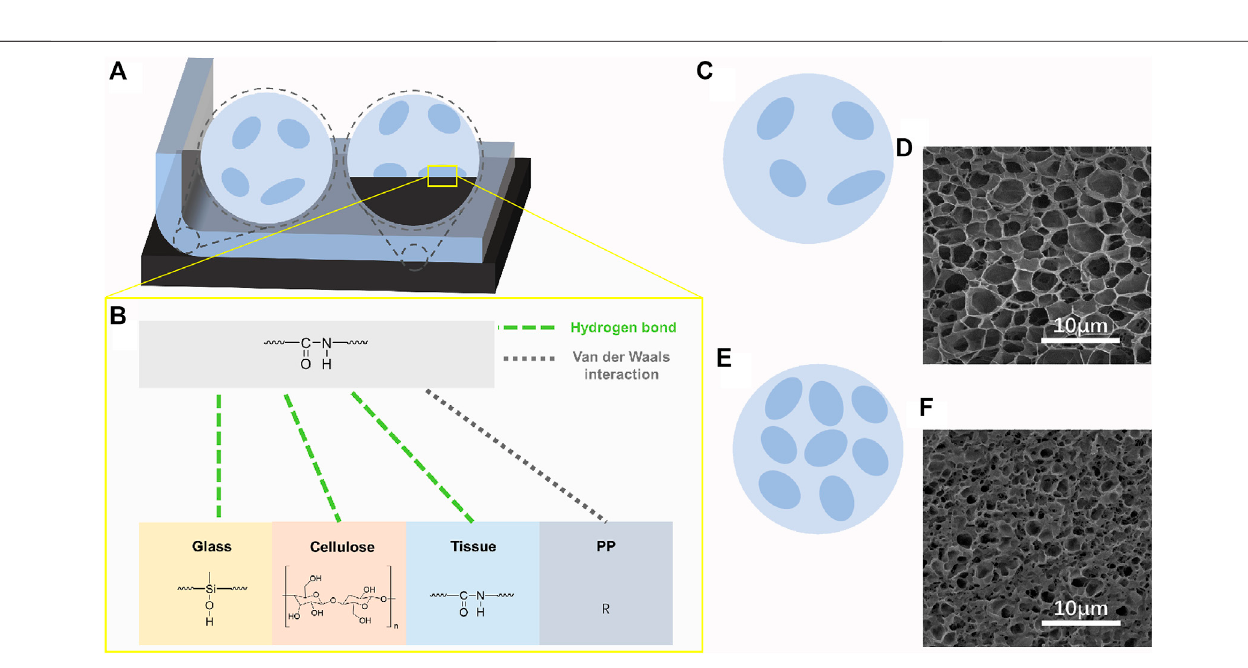
FIGURE 6 | (A) Schematic of peeling the EMWPUG from the substrate. (B) Potential chemical bonds between hydrogels and different materials, including hydrogen bond and Van der Waals interaction. Schematic and pore structure of medium crosslink density hydrogel (C,D) and high crosslink density (E,F) .